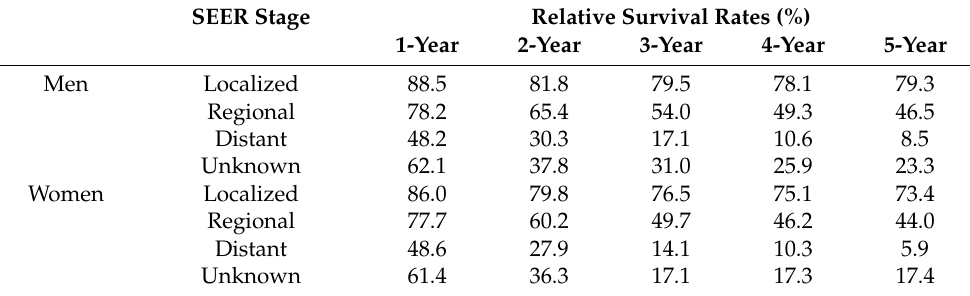
Table 5. Relative survival rates of patients with colon signet-ring cell carcinoma between 1993 and